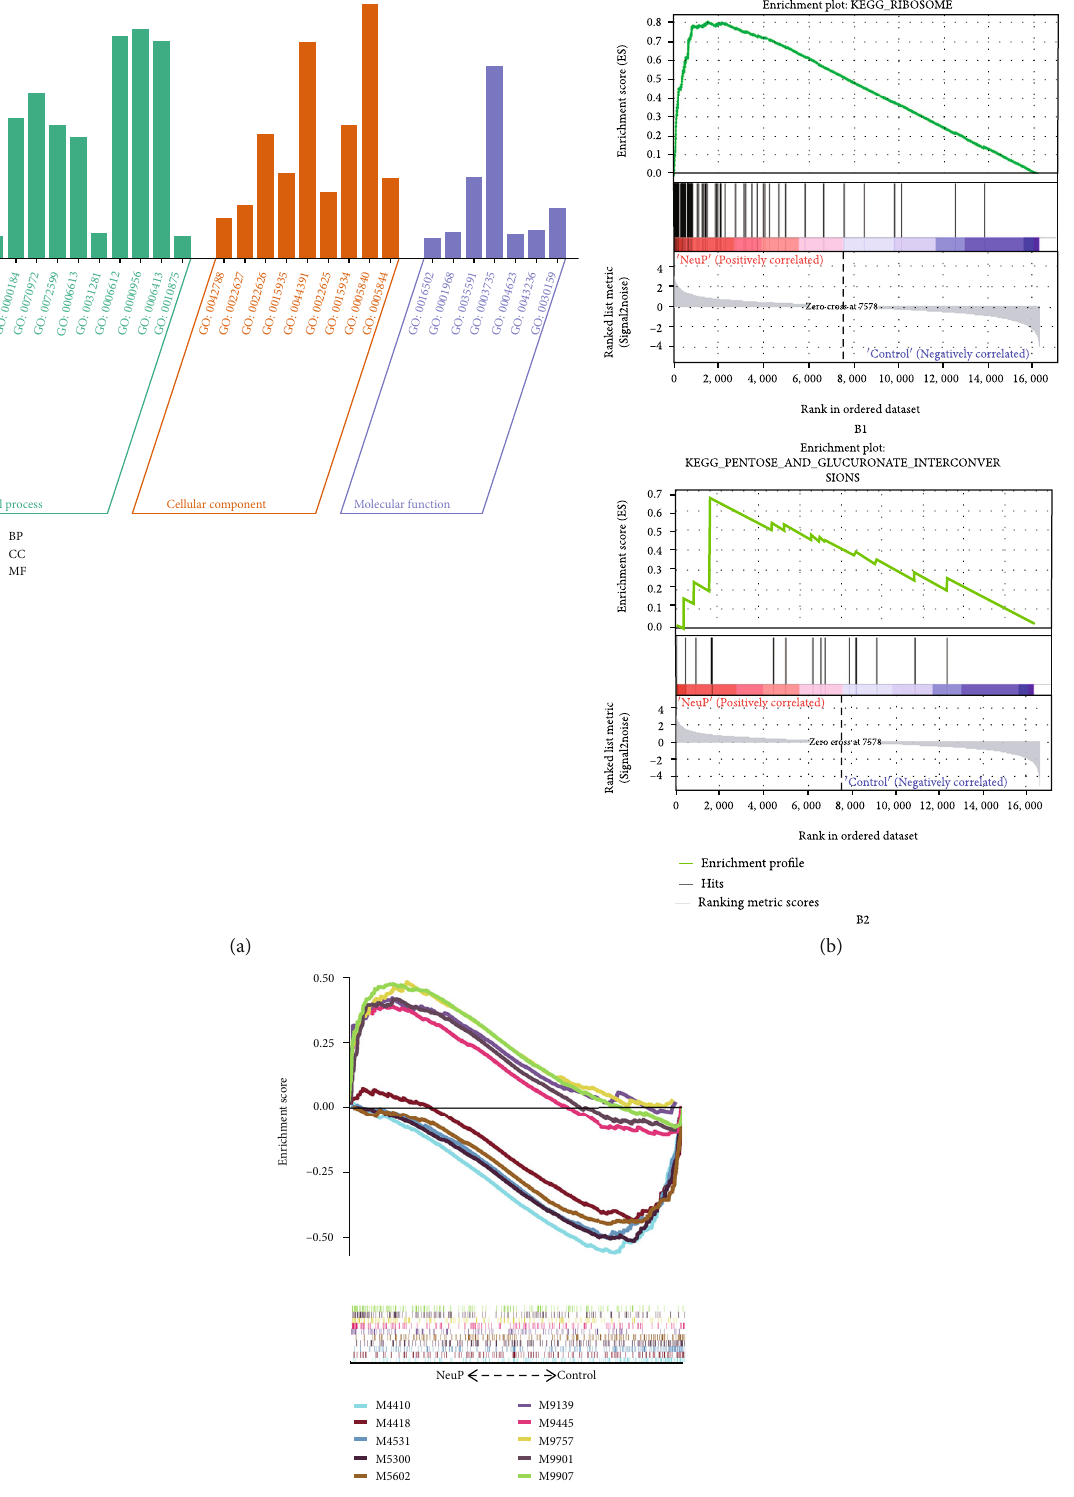
Figure 6: Results of GSEA enrichment analysis: (a) GO term plot of GO enrichment analysis; (b1) enrichment plot of ribosome pathway in KEGG analysis; (b2) enrichment plot of pentose and glucuronate interconversions pathway in KEGG analysis; (c) multiGSEA enrichment plot in IC